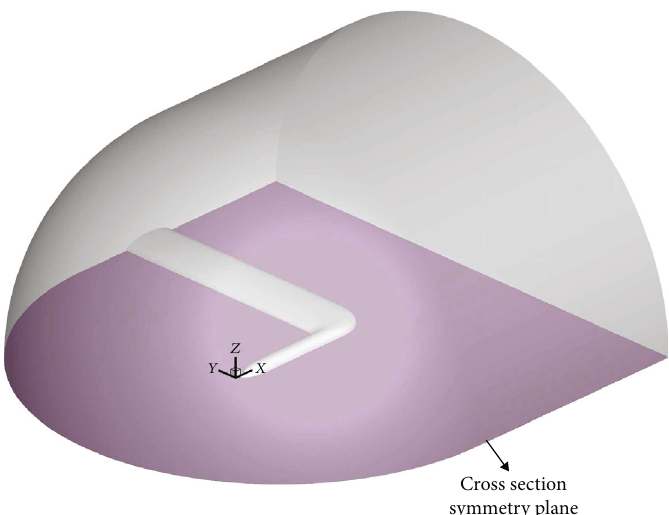
Cross section symmetry plane